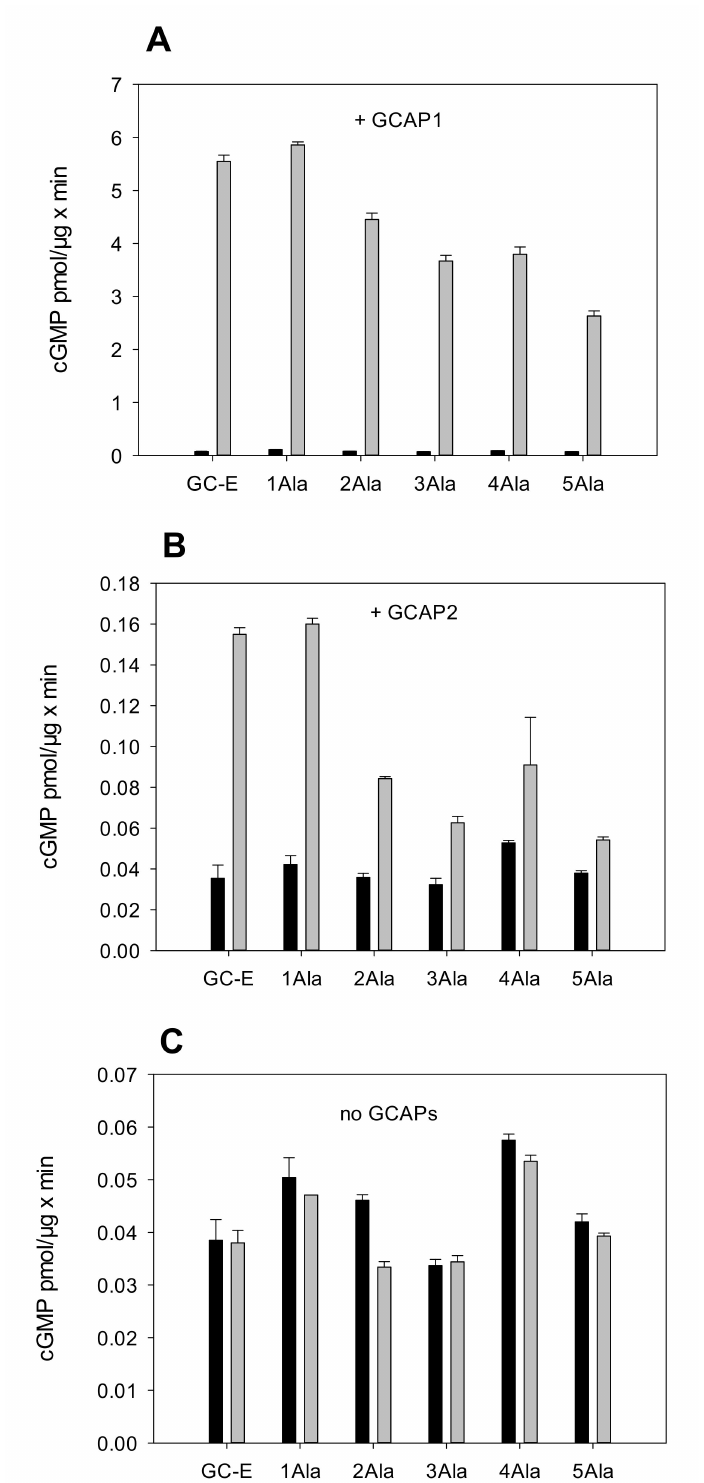
Figure 2. GC activities of Ala mutants and WT human GC-E. ( A ) Ala mutants were incubated at low (<10 nM, grey bars) and high (33 µ M, black bars) free [Ca 2+ ] in the presence of 5 µ M human GCAP1 ( n = 3). Control incubation of WT GC-E with GCAP1. ( B ) Similar to A, GCAP2 was present instead of GCAP1 ( n = 3). ( C ) Incubation of Ala mutants and WT GC-E in the absence of GCAPs at high and low [Ca 2+ ] ( n = 3). Results show basal GC activities that indicate no activating effect by the insertion of Ala